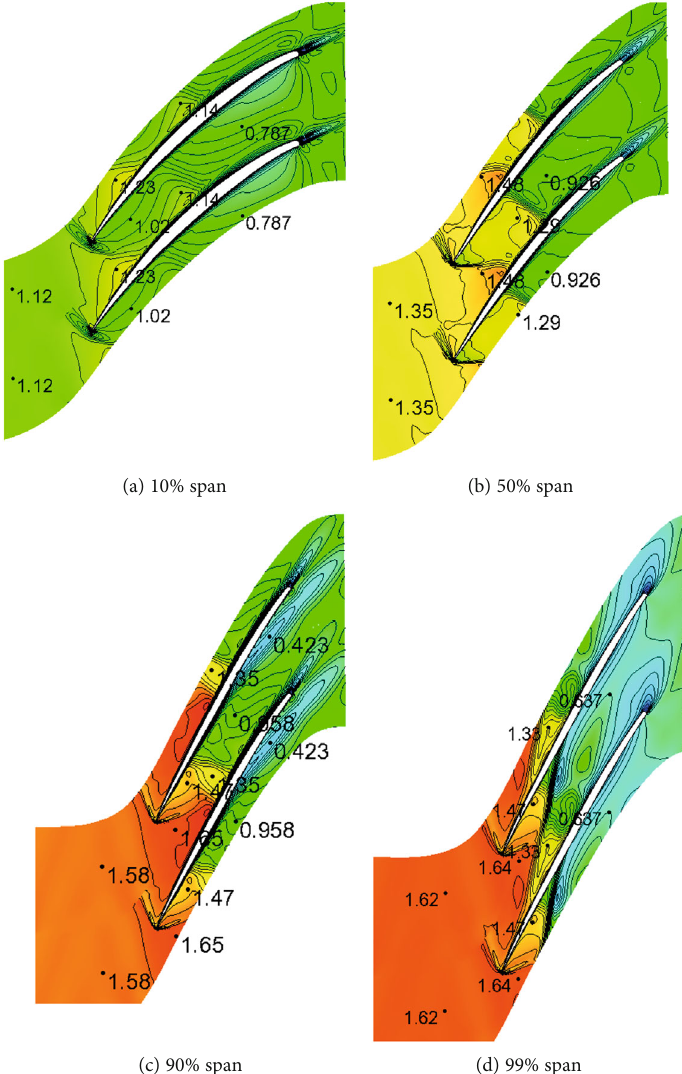
Figure 11: Mach number contours of 3D-opt rotor at stall point on S1